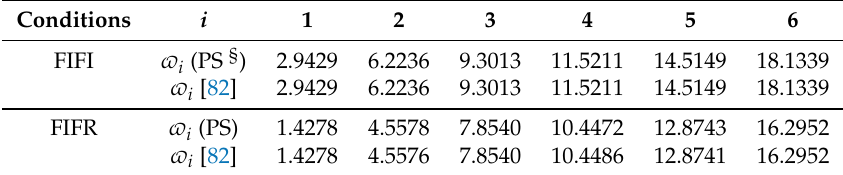
, χ 2 = 0, H y = H z = 0). 2 1